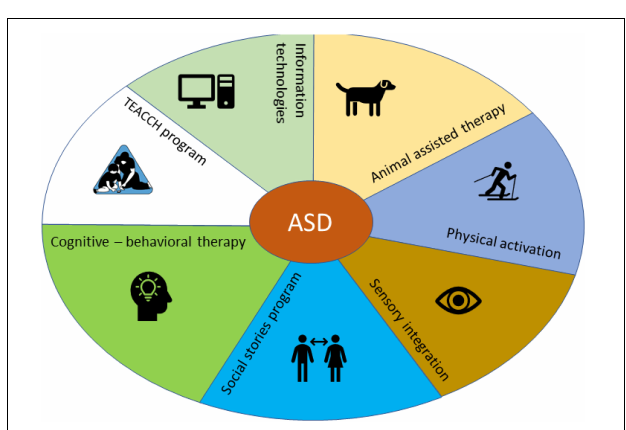
FIGURE 2 | The therapeutic interactions for patients with